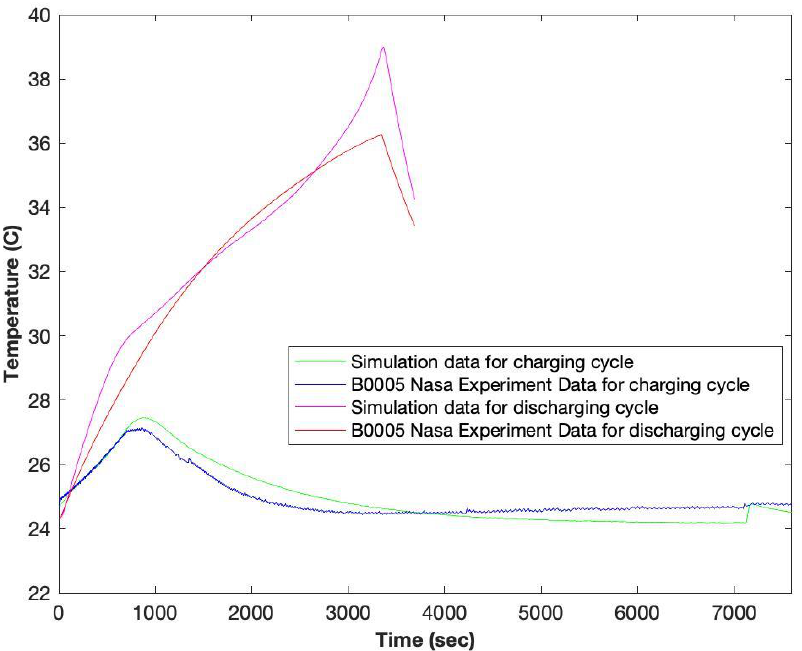
Figure 10. The charging battery temperature profiles of the proposed and the experimental models for the charging/discharging cycles.